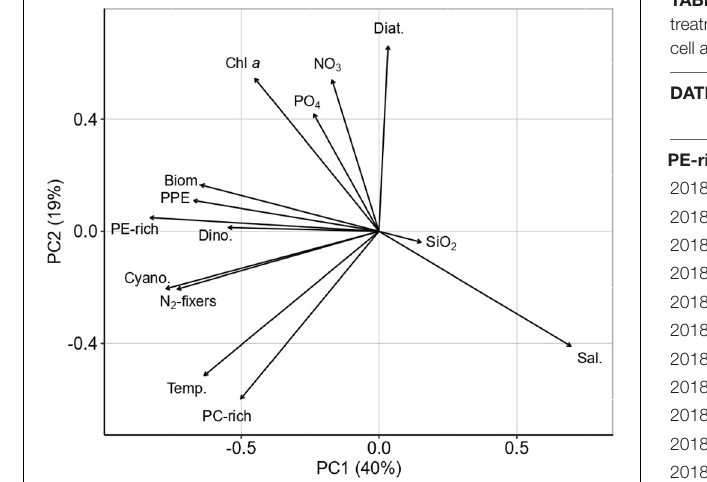
FIGURE 4 | Principal component analysis ordination plot (PC1 × PC2) of PE-rich, PC-rich, PPE, NO 2 + NO 3 , PO 4 , SiO 2 , temperature, salinity, phytoplankton biomass (total phytoplankton biomass (Biom.), dinoflagellates (Dino.), diatoms (Diat), total cyanobacteria (Cyano), and N 2 -fixers), and Chl a .